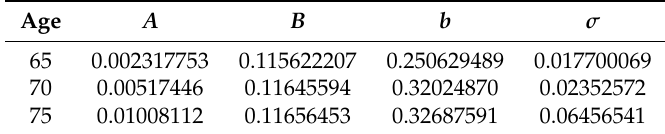
Table 2. Optimal parameters values for the survival function in the HW